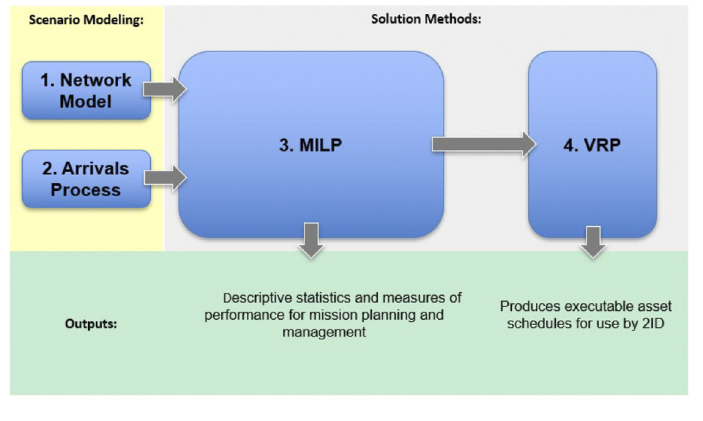
Figure 3. General solution procedure and